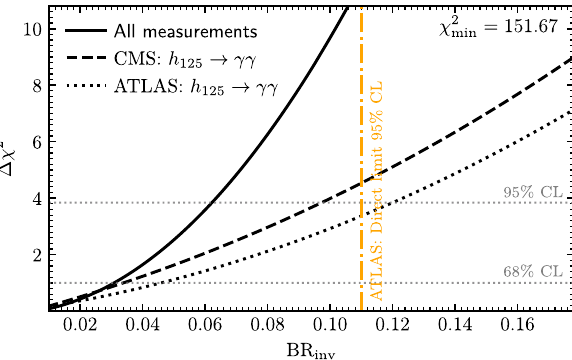
Fig. 1 Result of the global fit to the Higgs boson signal-rate measure- ments assuming a Higgs boson h 125 that apart from the presence of an invisible decay mode behaves according to the predictions of the SM model, i.e. the couplings of h 125 to the SM particles are unchanged. The black solid line indicates the value (cid:10)χ 2 taking into account the full HiggsSignals data set. The black dashed and the black dotted lines indicate the value of (cid:10)χ 2 considering only the measurements in the diphoton final state utilizing the full Run 2 data by CMS [56] and ATLAS [57], respectively. The gray horizontal lines indicate the 68% and 95% CL, respectively. The orange vertical line indicates the cur- rently strongest upper limit on BR inv resulting from direct searches for h 125 → inv as published by ATLAS [33]